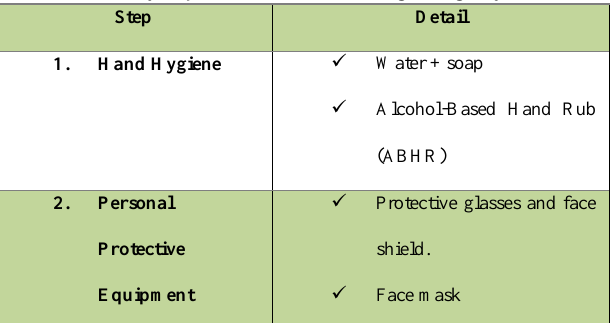
Table 3. Necessary steps to be conducted during emergency